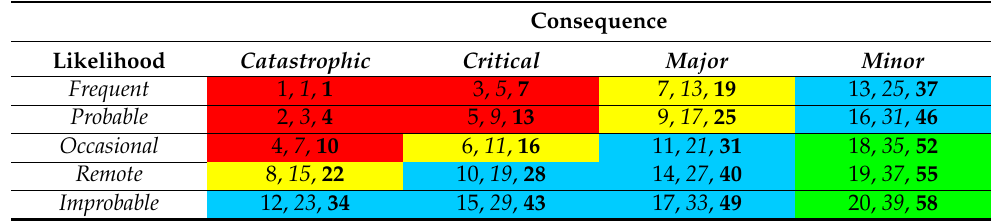
Table 7. Risk Matrix.